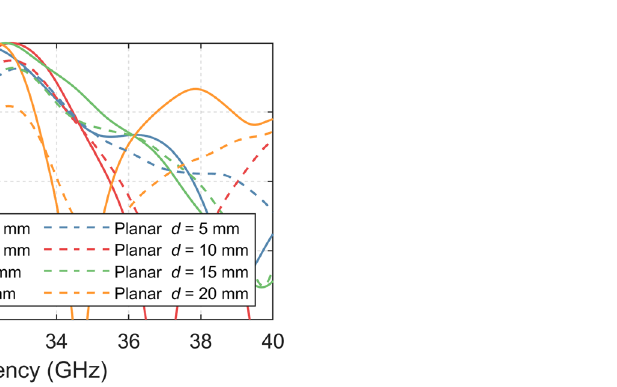
Figure. 3. (a) Side view (YZ plane) of the finite planar FSS; (b) view from the receiver (XY plane); and (c) simulated S21 of the finite planar FSS as a function of distance and frequency, with contour lines indicates the -3 dB and -10 dB transmission bandwidth.